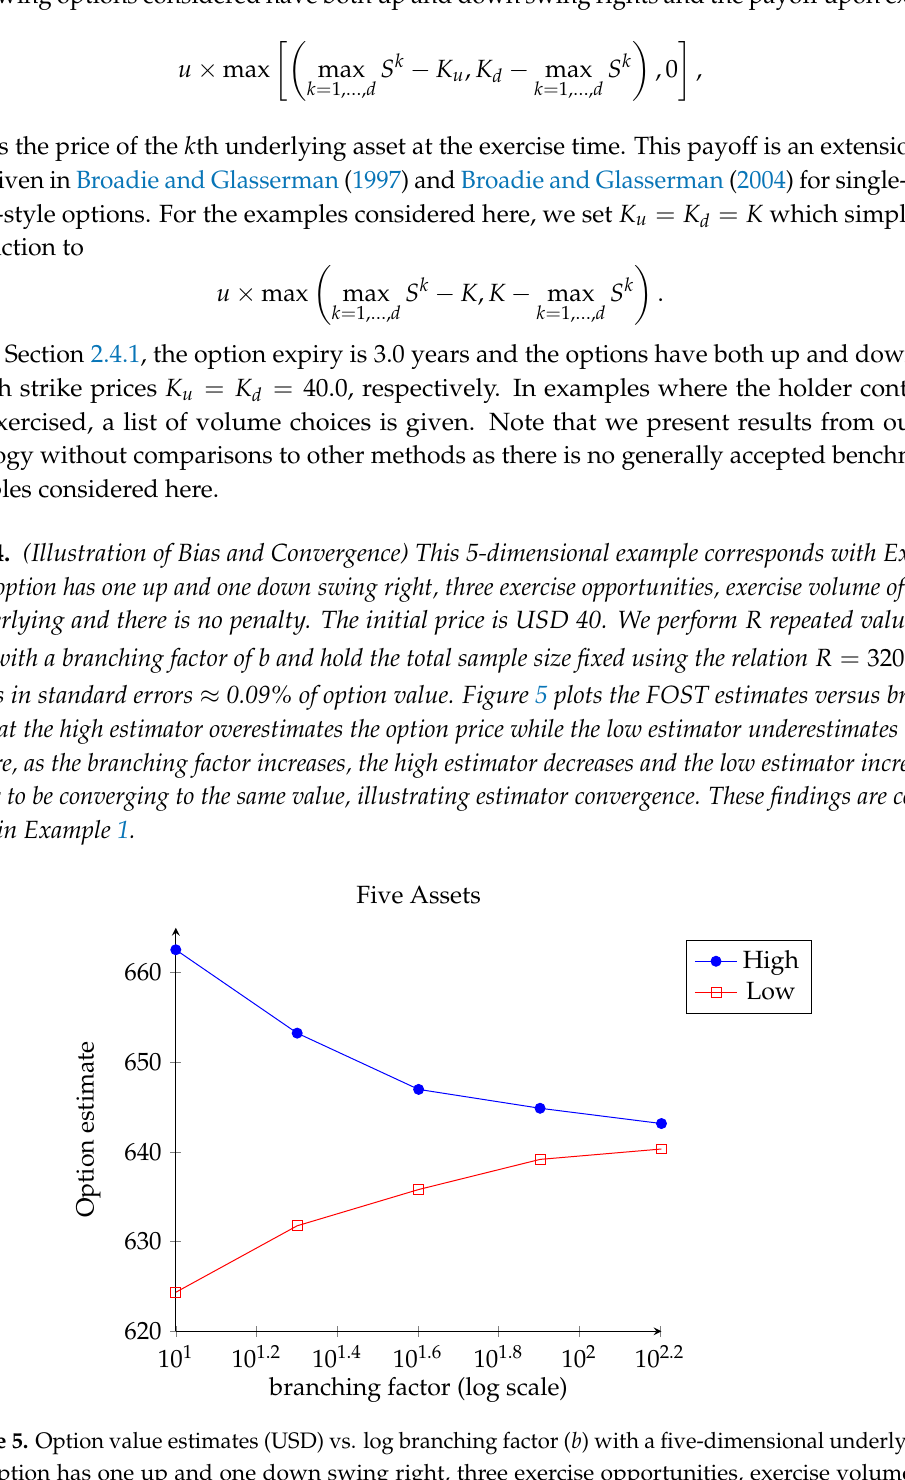
(cid:16) (cid:17) 10 results in b